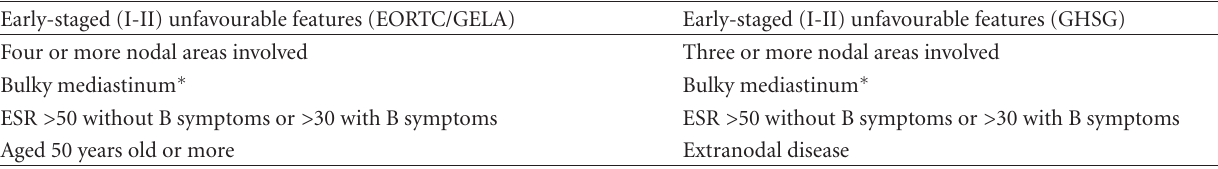
Table 1: EORTC/GELA and GHSG risk factors for early-staged